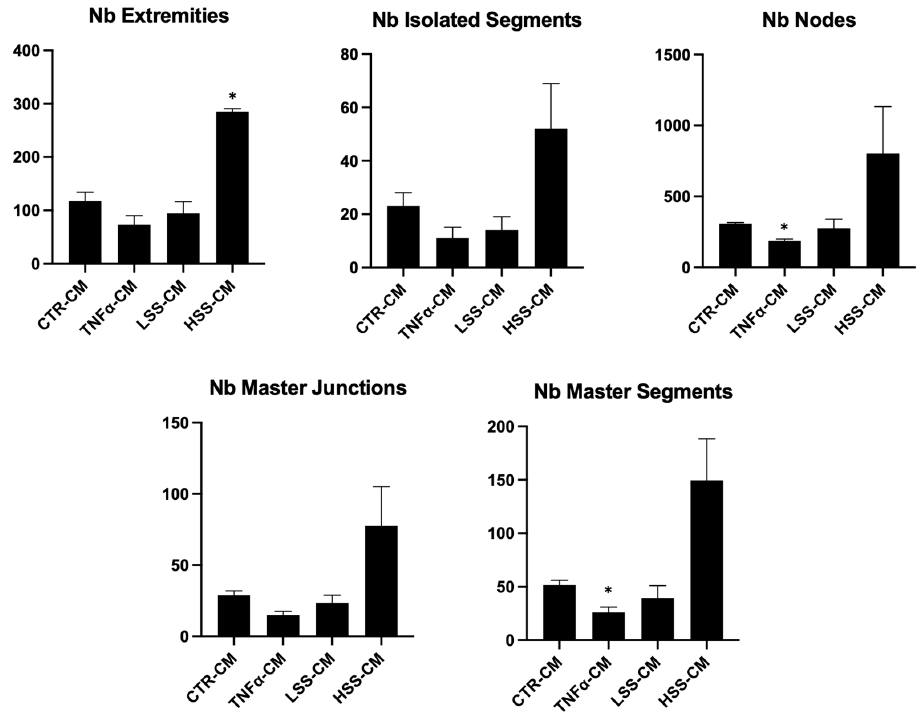
Figure 14. Angiogenesis analysis of tube formation images at 24 h. (* p < 0.05).